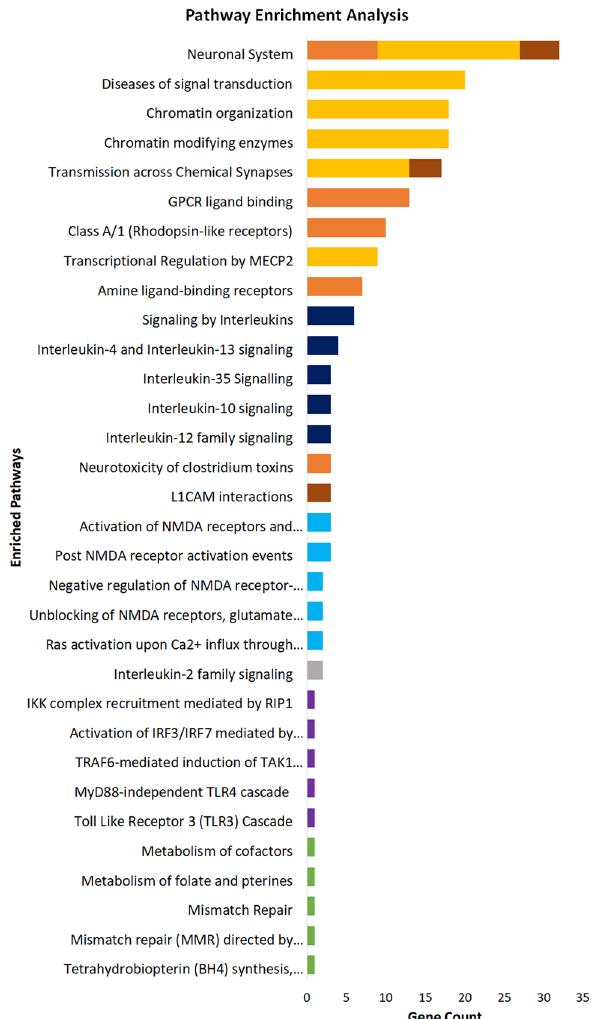
Figure 5. Pathway enrichment analysis of neuropsychiatric and neurological disorders using ReactomePA. Bar plot of the 5 most significant results from pathway enrichment analysis of each neuropsychiatric and neurological datasets after Matrix-GC. The following disorders are represented: attention deficit hyperactivity disorder (ADHD, Orange), bipolar disorder (BIP, Brown), Alzheimer’s disease (AD, Grey), multiple sclerosis (MS, Dark Blue), Parkinson’s disease (PD, Light Blue) Huntington’s disease (HD, Green) and amyotrophic lateral sclerosis (ALS, Purple), autism database (ASD-SFARI, Yellow). Full statistical results from ReactomePA can be found in the Supplementary Information files. Control permutation analysis was carried out on randomly generated and size-matched, from hg19 human reference genome and exome